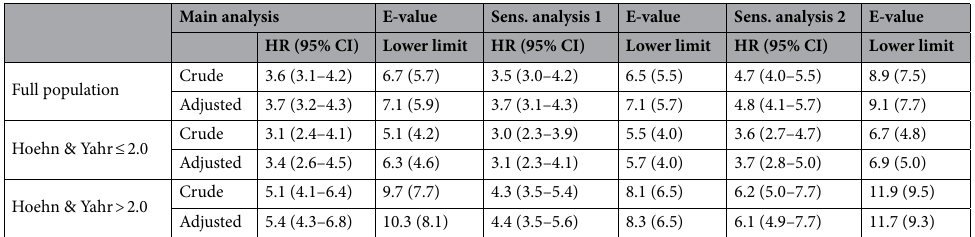
Table 3. Hazard ratios and 95% confidence intervals for time to dementia. HR hazard ratio, CI confidence interval, Sens. analysis 1 2 or more records of a dementia coded event, Sens. analysis 2 dementia defined prescribed a N06D anti-dementia